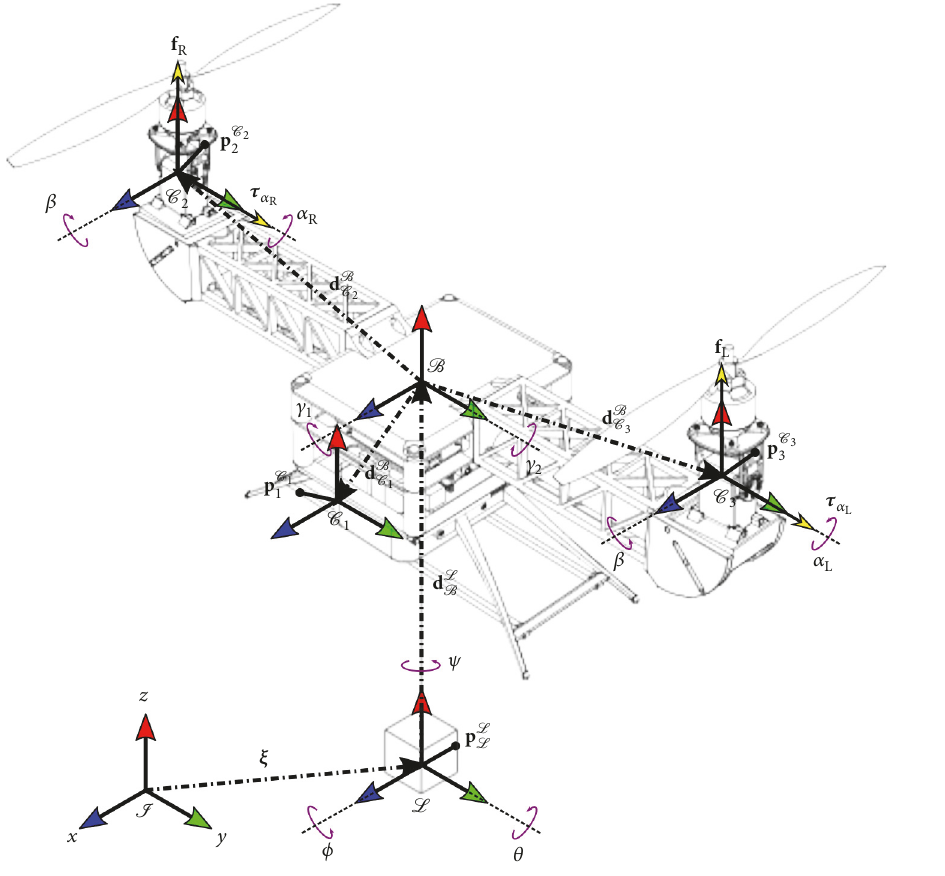
Figure 2: Kinematic definitions, input forces, and